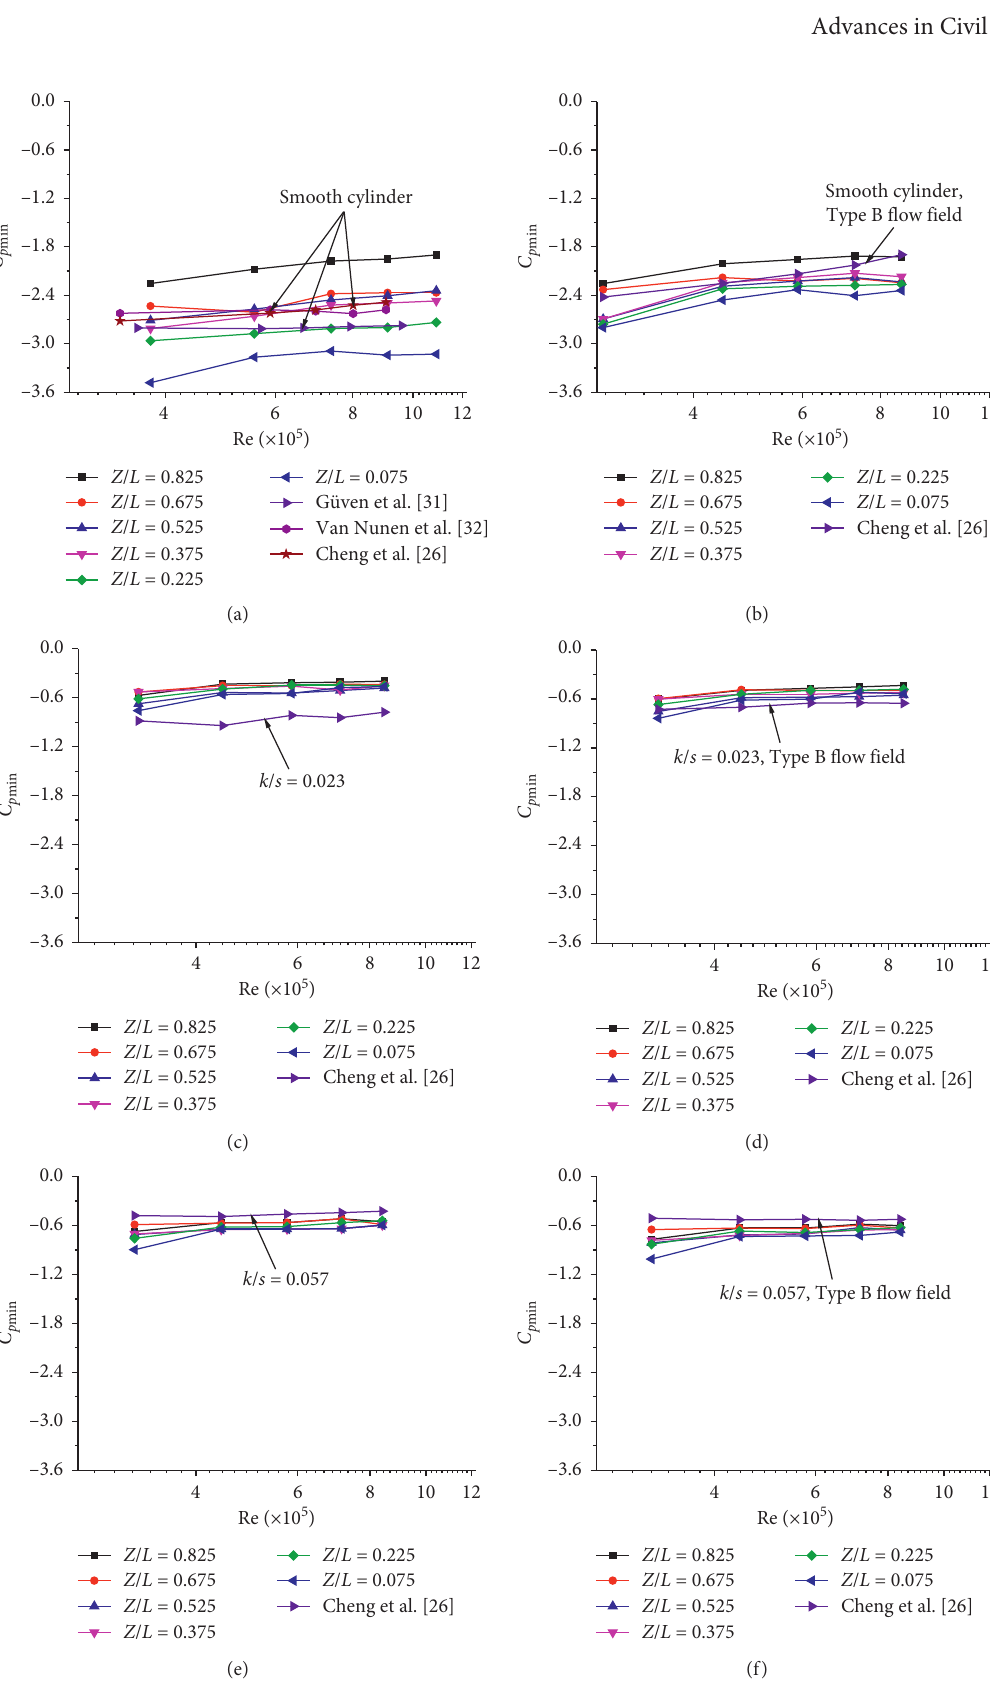
Figure 9: Effect of the Reynolds number on minimum negative wind pressure coefficient. (a, c, e) Uniform flow and (b, d, f) Type A turbulent flow field. (a, b) c � 0, (c, d) c � 0.0386, and (e, f) c �